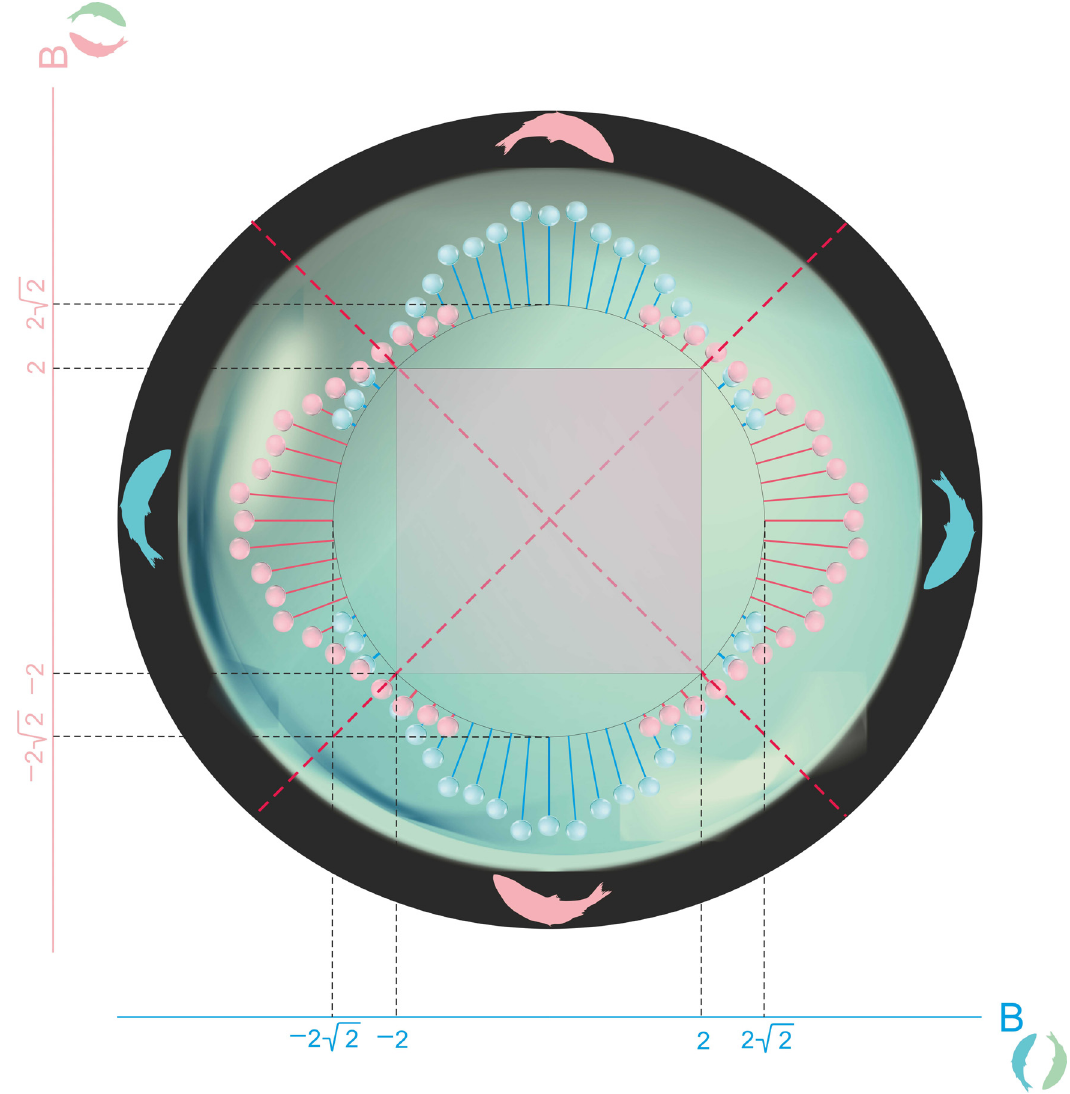
Fig 4. An agent-based simulation of monogamy of survival in a 3-specie population dynamics game. The axes represent the values of the Bell parameters B and B . For each value of these parameters that lie on the circle defined by the saturation of Eq CV 1 CV 2 (8), the extinction probabilities of species V (greenish) and V (pinkish) are represented by the length of the corresponding pin. The 1 2 classical correlations are bounded by the square. The more one virus specie violates Bell’s inequality, the smaller become the odds of the other virus specie to